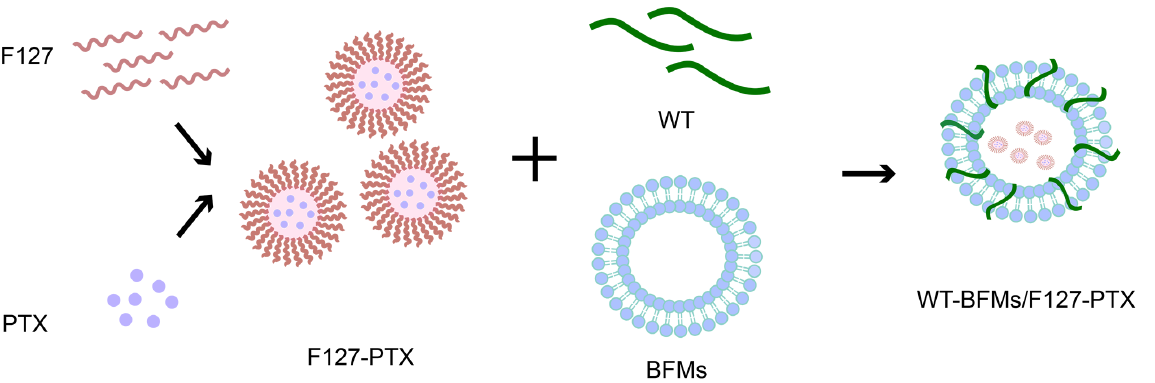
Figure 1. Schematic illustration of WT-BFMs/F127-PTX. PTX-loaded F127 micelles were prepared by the thin-film dispersion method. WT, F127-PTX micelles and BFMs were mixed and sonicated using ultrasonic homogenizer to form WT-BFMs/F127-PTX.